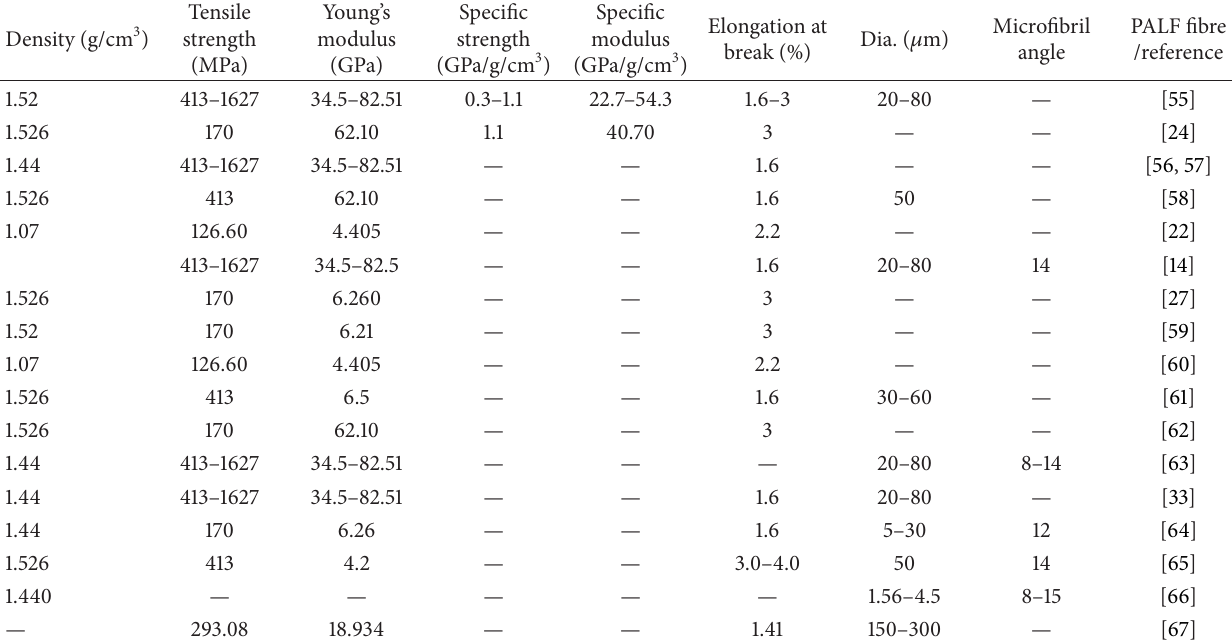
Table 7: Physical and mechanical strength of